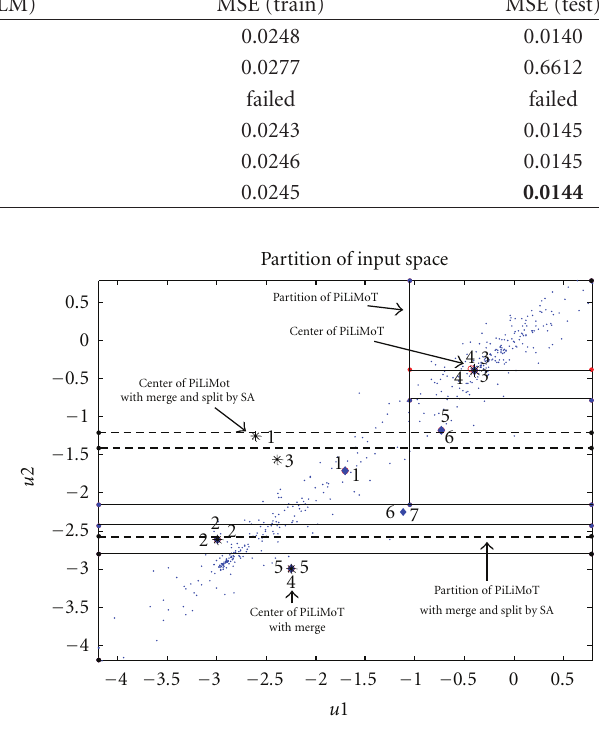
Figure 10: Neurons centers for PiLiMoT, PiLiMoT with Merge ability, and PiLiMoT with Merge ability, and modified spilt by